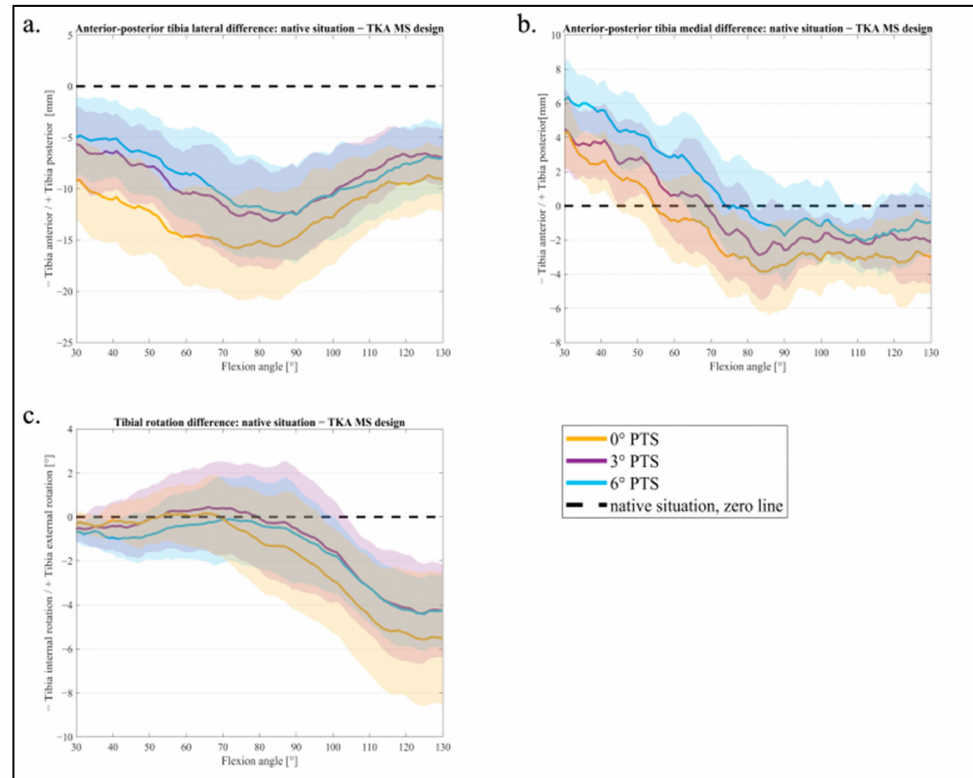
Figure 5. Mean values and 95 % confidence interval of difference of TKA to native situation: ( a ) anterior–posterior lateral tibial translation; ( b ) anterior–posterior medial tibia translation; ( c ) tibial rotation for 0 ◦ PTS (orange), 3 ◦ PTS (purple), 6 ◦ PTS (blue), and native situation (black) as the zero